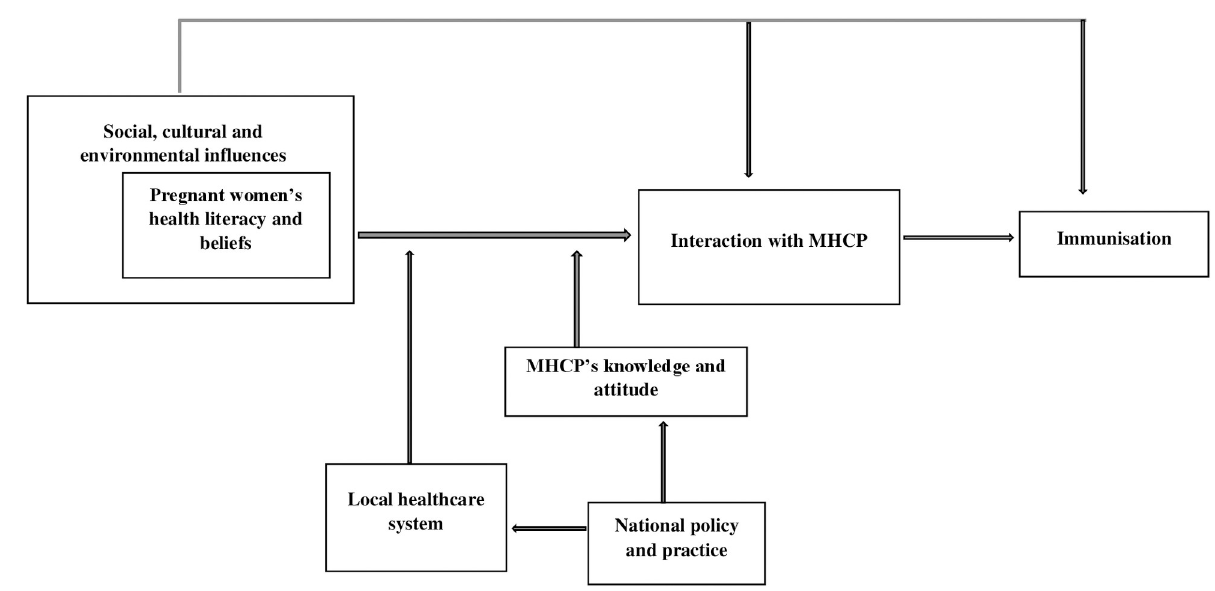
Fig 2. Illustrative model of analytical and descriptive themes. MHCP: Maternity healthcare